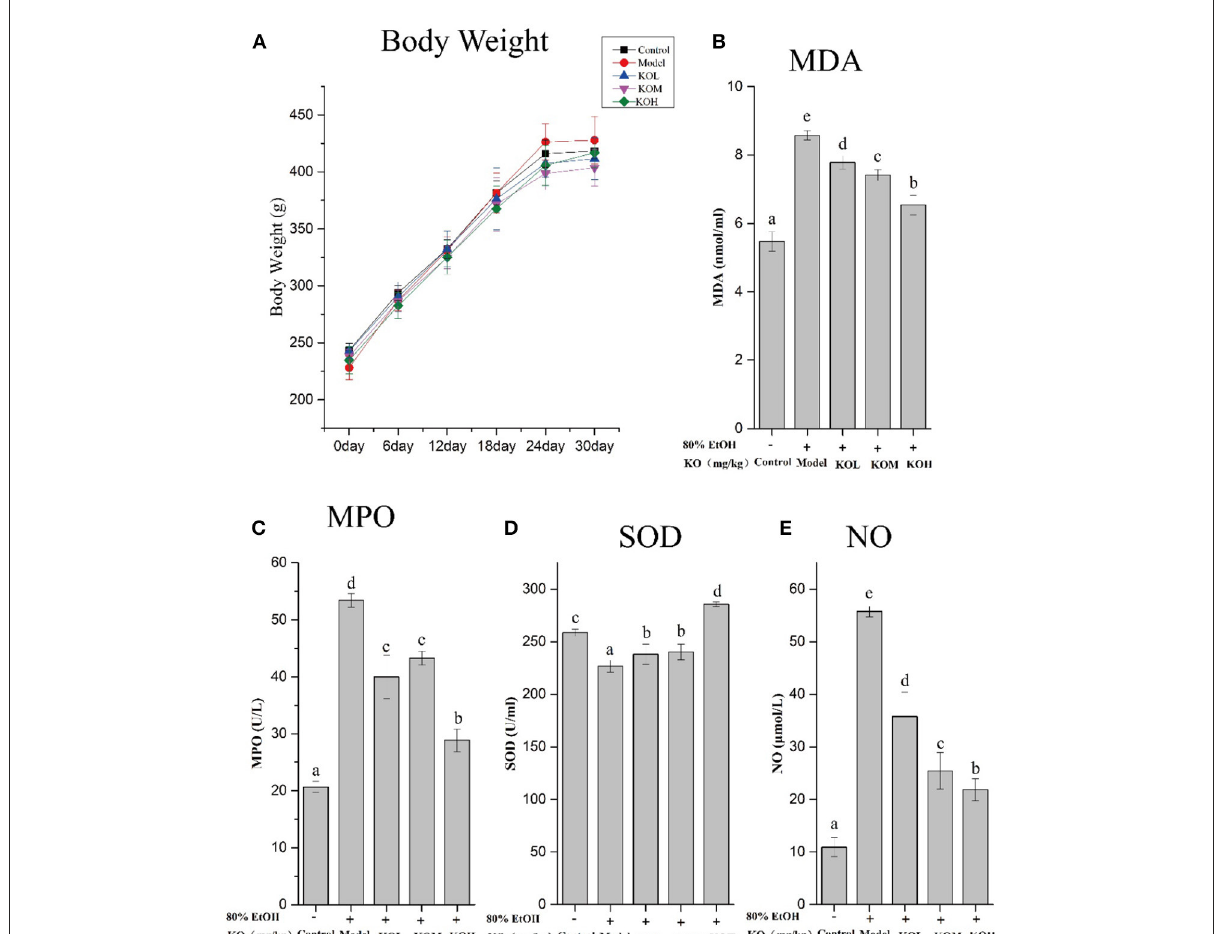
FIGURE3 Levels of MDA, SOD, MPO, and NO in ethanol-induced gastric mucosal damage in SD rats after gavaging KO for 30 d (A–E) , and the weight changes of SD rats. Different letter values ( n = 6; mean ± SEM) indicate statistically significant differences from the same column model group ( p < 0.05 ). KOL, krill oil of 100 mg/kg; KOM, krill oil of 200 mg/kg; KOH, krill oil of 500